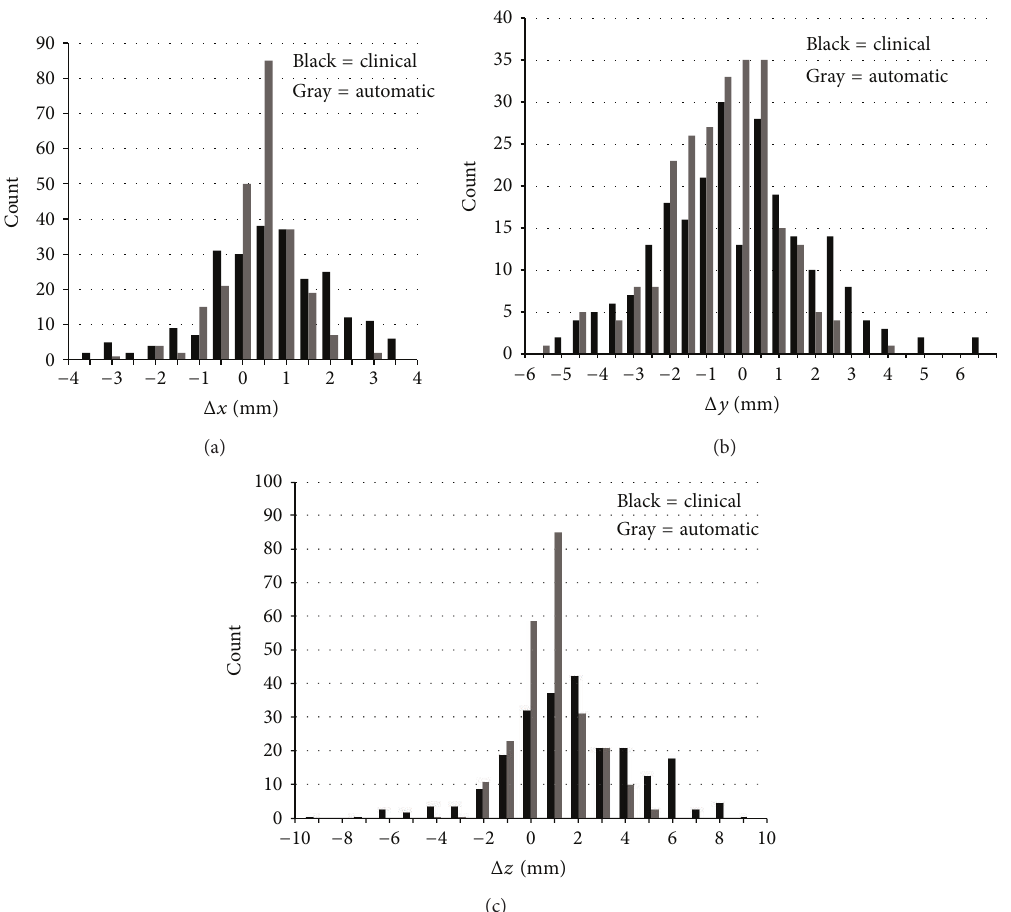
Figure 9: Frequency histograms for Δ𝑥, Δ𝑦 , and Δ𝑧 . The averages of the unsigned clinical values for Δ𝑥, Δ𝑦 , and Δ𝑧 , respectively, are 1.06mm, 1.79 mm, and 2.54 mm. The averages of the automatic values are 0.58 mm, 1.14mm, and 1.05 mm. Two clinical values are outside the Δ𝑦 axis range and seven values are outside the Δ𝑧 range. All of the automatic results are within the ranges of all